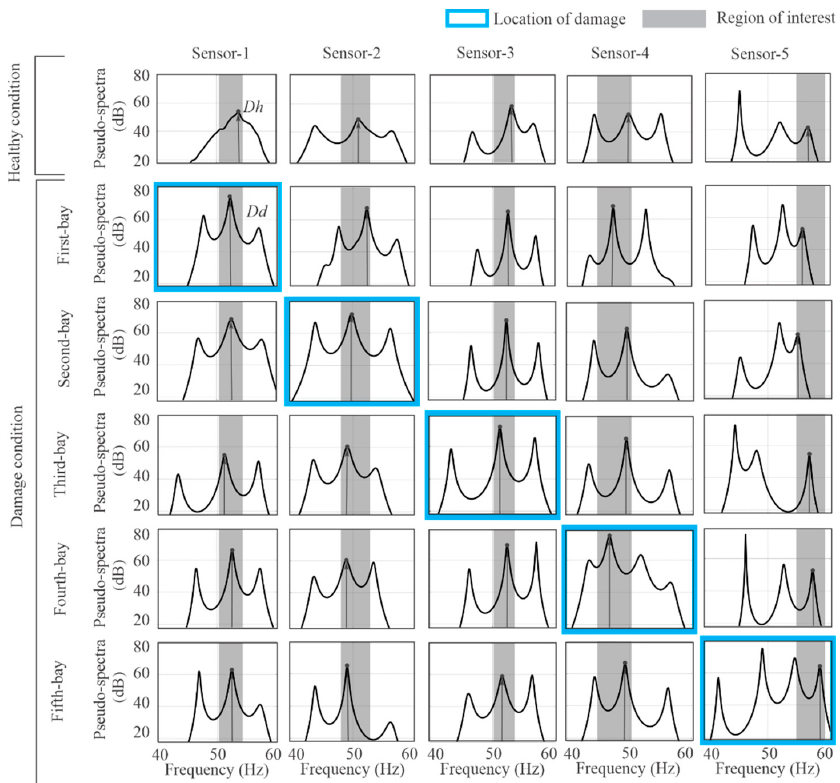
Figure 13. Pseudo-spectra obtained from the IC scenario and used to identify condition–location of damage.